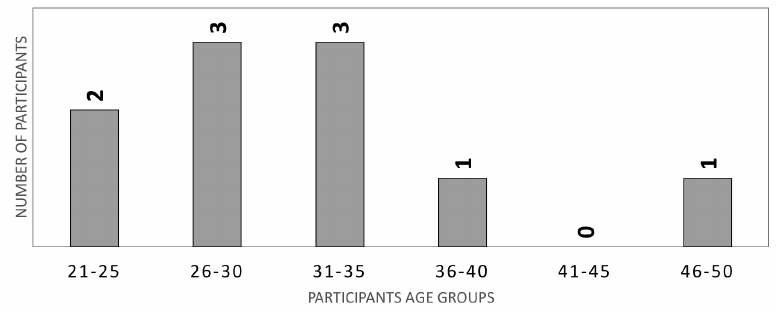
Figure 11. Distribution of participants according to their age group.